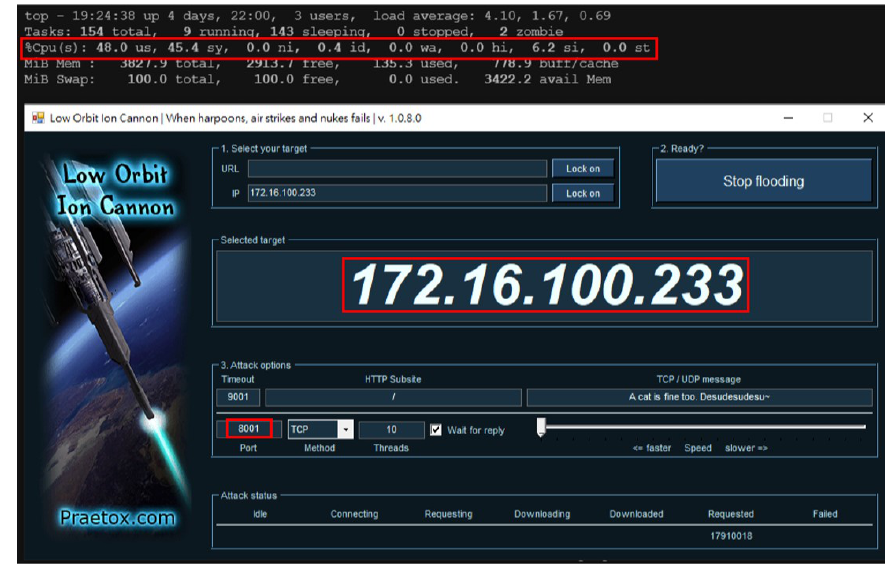
Figure 9. SCADA server without TEVM